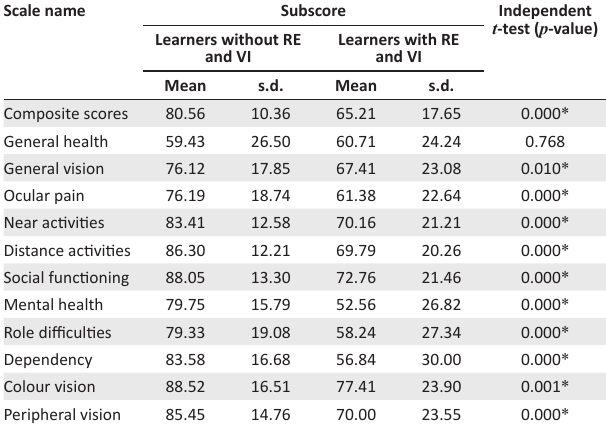
TABLE 3: Comparison of the mean and standard deviation (s.d.) between the learners with refractive error (RE) or visual impairment (VI) and those without, based on the subscores of the items of the National Eye Institute Quality of Life